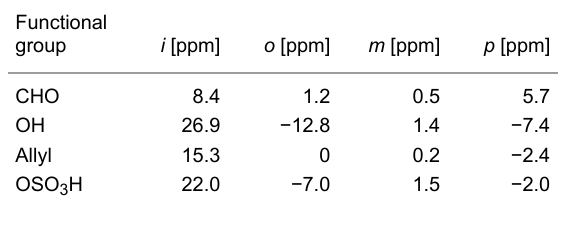
Table 2: 13 C substituent effects Δδ in monosubstituted benzenes rela- tive to the benzene carbon at 128.5 ppm [9]. Functional